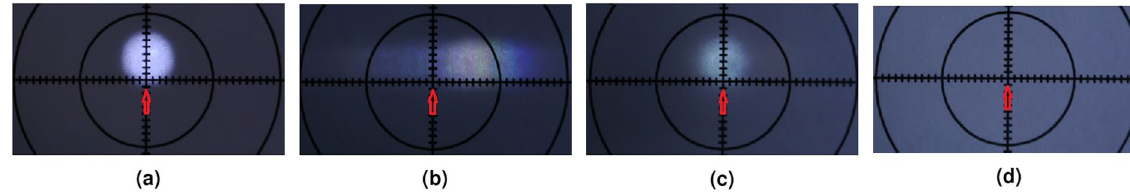
Figure 2. Collimated white light beam steering of Ch-LC-grating devices with E7 NLC and R5011 chiral dopant: ( a ) Original beam spot; ( b ) Beam deflection of Ch-LC steerer with V app = 0; ( c ) Beam deflection of Ch-LC steerer with V app = 200 V pp ; ( d ) Beam scattering of Ch-LC steerer when the high voltage is removed abruptly.